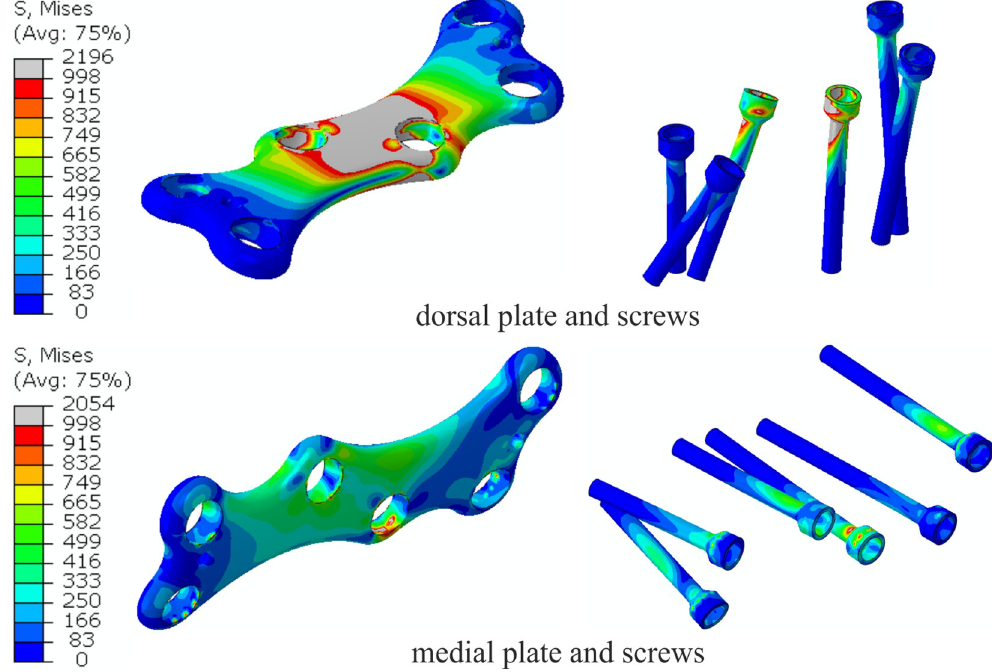
Fig 12. Detailed view of the effective stress [MPa] distribution in the plates and screws for both plate positions.